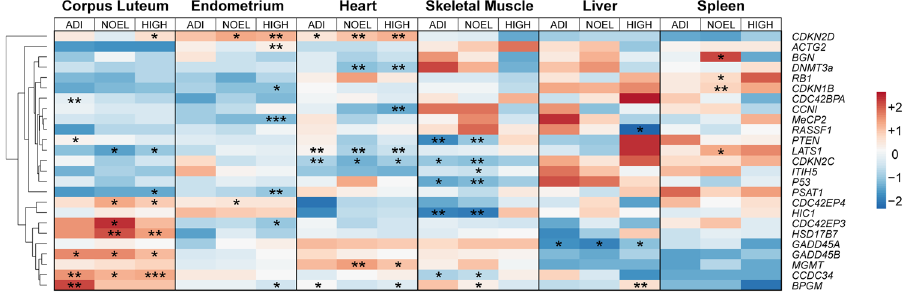
Figure 2. Heat map using hierarchical clustering of differentially expressed genes (DEG) in F 0 tissues. Left to Right: Corpus luteum, endometrium, heart, skeletal muscle, liver, and spleen, where rows represent genes and columns represent the centred mean log-fold changes per treatment group compared to the control (0.05, 10, and 1000 μ g/kg body weight/day represented by ADI, NOEL, and HIGH dose, respectively). * , ** , and *** indicate statistical significance with respect to the control group at p < 0.05, p < 0.01, and p < 0.001, respectively (n = 4–6 per